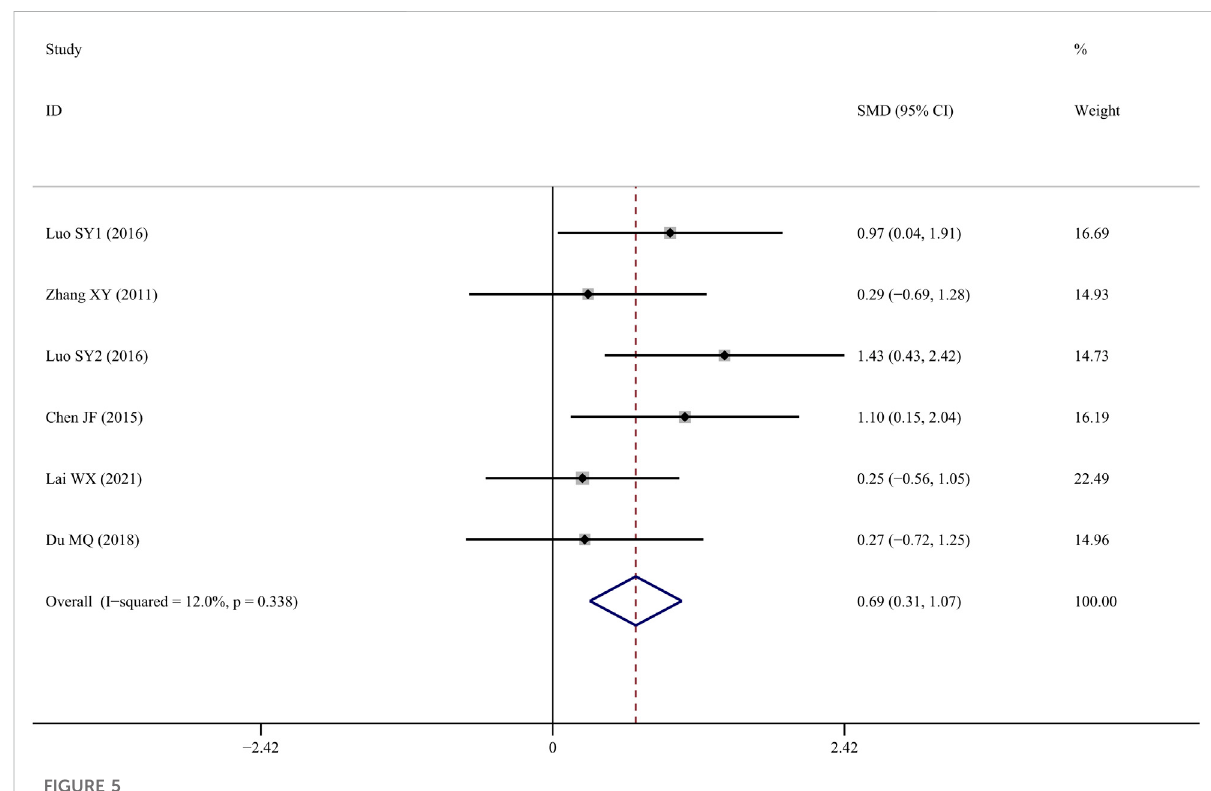
FIGURE 5 Effect of tanshinol on Tb.N change in OP